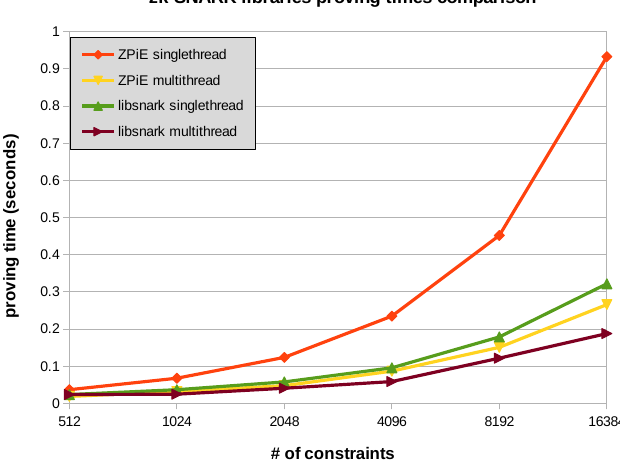
Figure 3. ZPiE and libsnark proving times comparison using different constraint amounts, single- thread and multi-thread modes. All the tests are executed using a i7-11370H CPU. The used zk- SNARK is Groth’16, and the elliptic curve BN128.